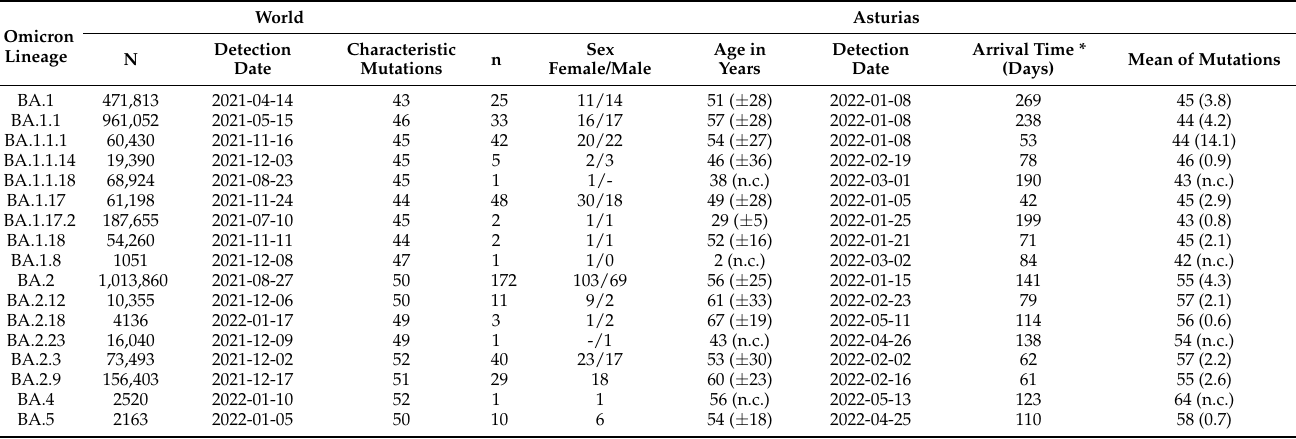
Table 1. Characteristics of Omicron variants BA.1 and BA.2 uploaded to GISAID in Asturias and the rest of the world between January to June 2022. Characteristic mutations are those defined by Pangolin.